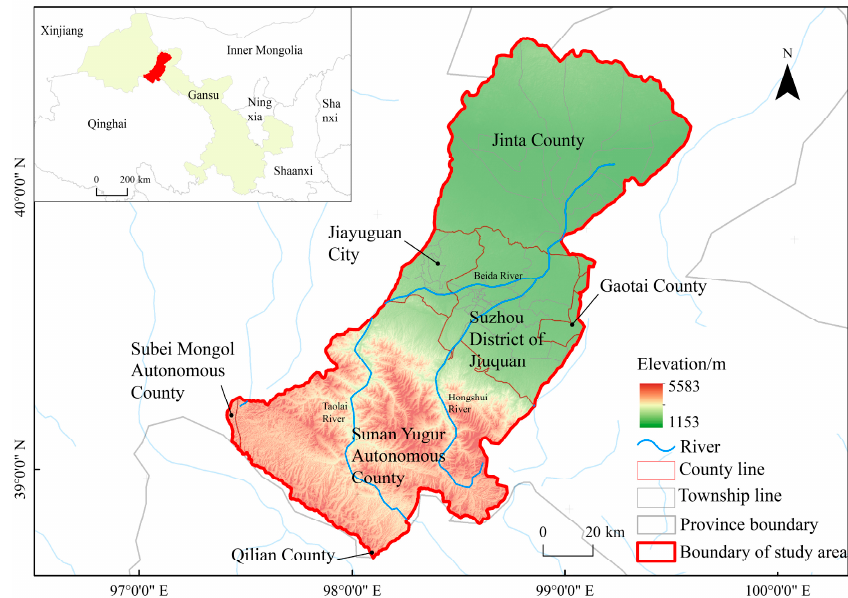
Figure 1. Overview of the study area.